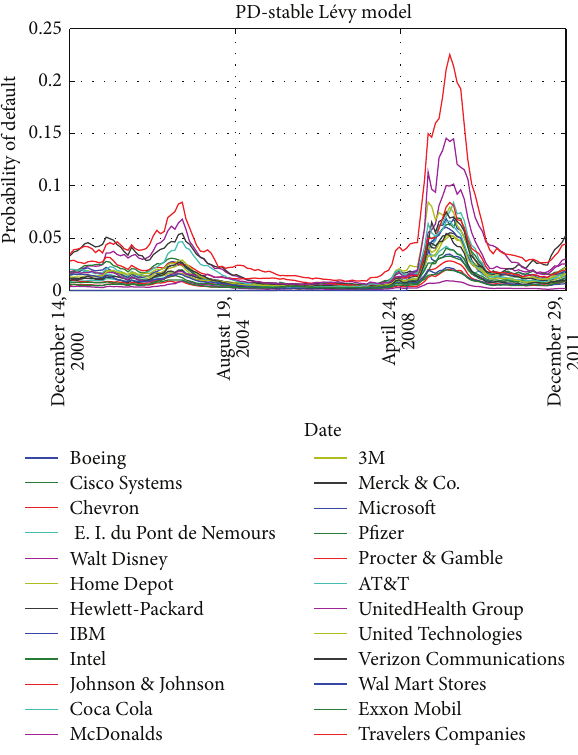
Figure 2: PDs-stable L´evy